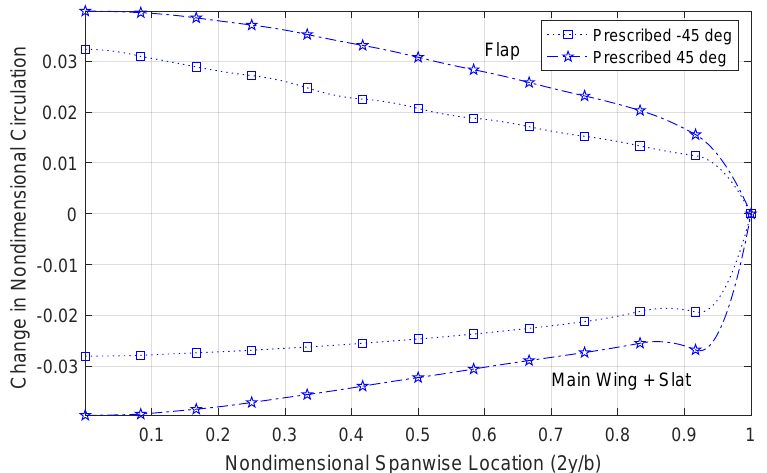
Figure 19. Predicted changes in the spanwise circulation distributions due to an increase in flap deflection angle for the NASA Trap Wing, according to ∆Γ = Γ Config 1 − Γ Config 8 , C L =